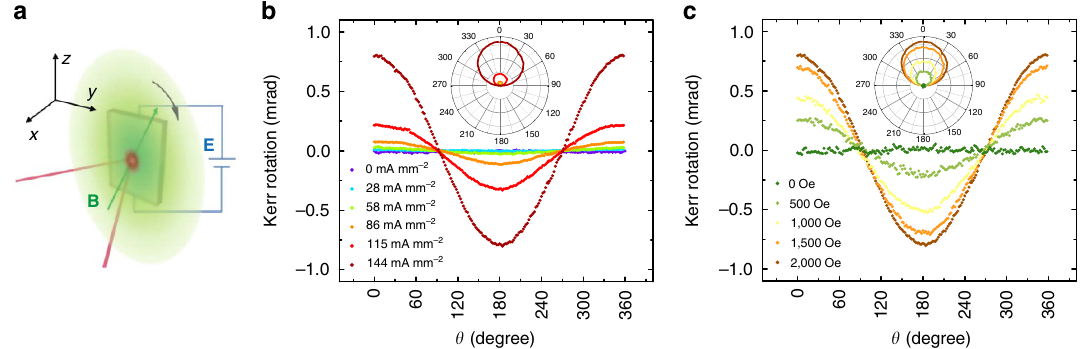
Figure 6 | Illustration of the MOKE experimental set-up and ROT-MOKE data of the Cd 3 As 2 bulk crystals. ( a ) Schematic drawing of the MOKE experimental set-up. The magnetic field is rotated in the y - z plane, parallel to the sample surface. A constant current density was applied across the sample. The incident laser is p -polarized with a wavelength of 670nm. ( b and c ) ROT-MOKE signals of the Cd 3 As 2 crystals under different current density and magnetic field, adopting a cosine-function dependence on y . Here y is defined as the angle between E and B . For ( b ) the magnetic field was fixed at 2,000Oe and for ( c ) the current density is fixed at 144mAmm (cid:3) 2 . The insets are the data plotted in the